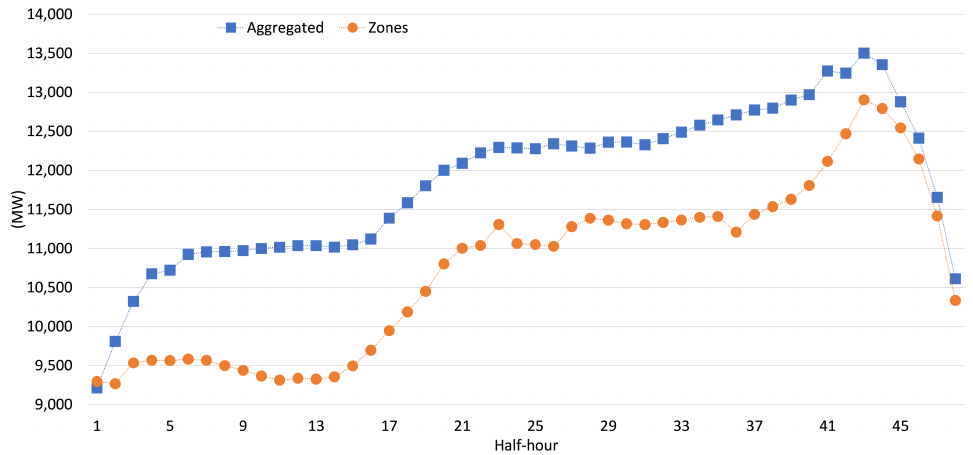
Figure 11. Thermal generation in Case 1 Trial 1.